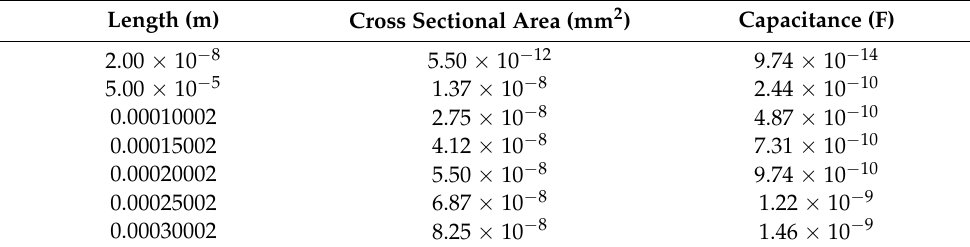
Figure 2. ( a ) electrical model of the solder ball ( b ) electrical model of the crack in solder ball. The value of the capacitance depends on the cross sectional area of the crack and the height of the crack. The capacitance values for cracks of various lengths and cross sectional areas are shown in Table 1. The solder ball has diameter of 0.35 mm. The height of the crack is 0.5 nm. The value of the capacitance in Table 1 is calculated by C = ε r ∗ ε 0 ∗ A c /d. Where A c is the area of cross section of the cracked part of the solder ball, d is the height of the crack. ε r is relative permittivity for air and it has a value of 1.0005. ε 0 is the permittivity for vacuum and it has a value of 8.854 × 10 − 12 F/m [16]. Table 1 shows that the capacitance due to crack increases as the length of the crack increases. Table 1. Crack capacitance